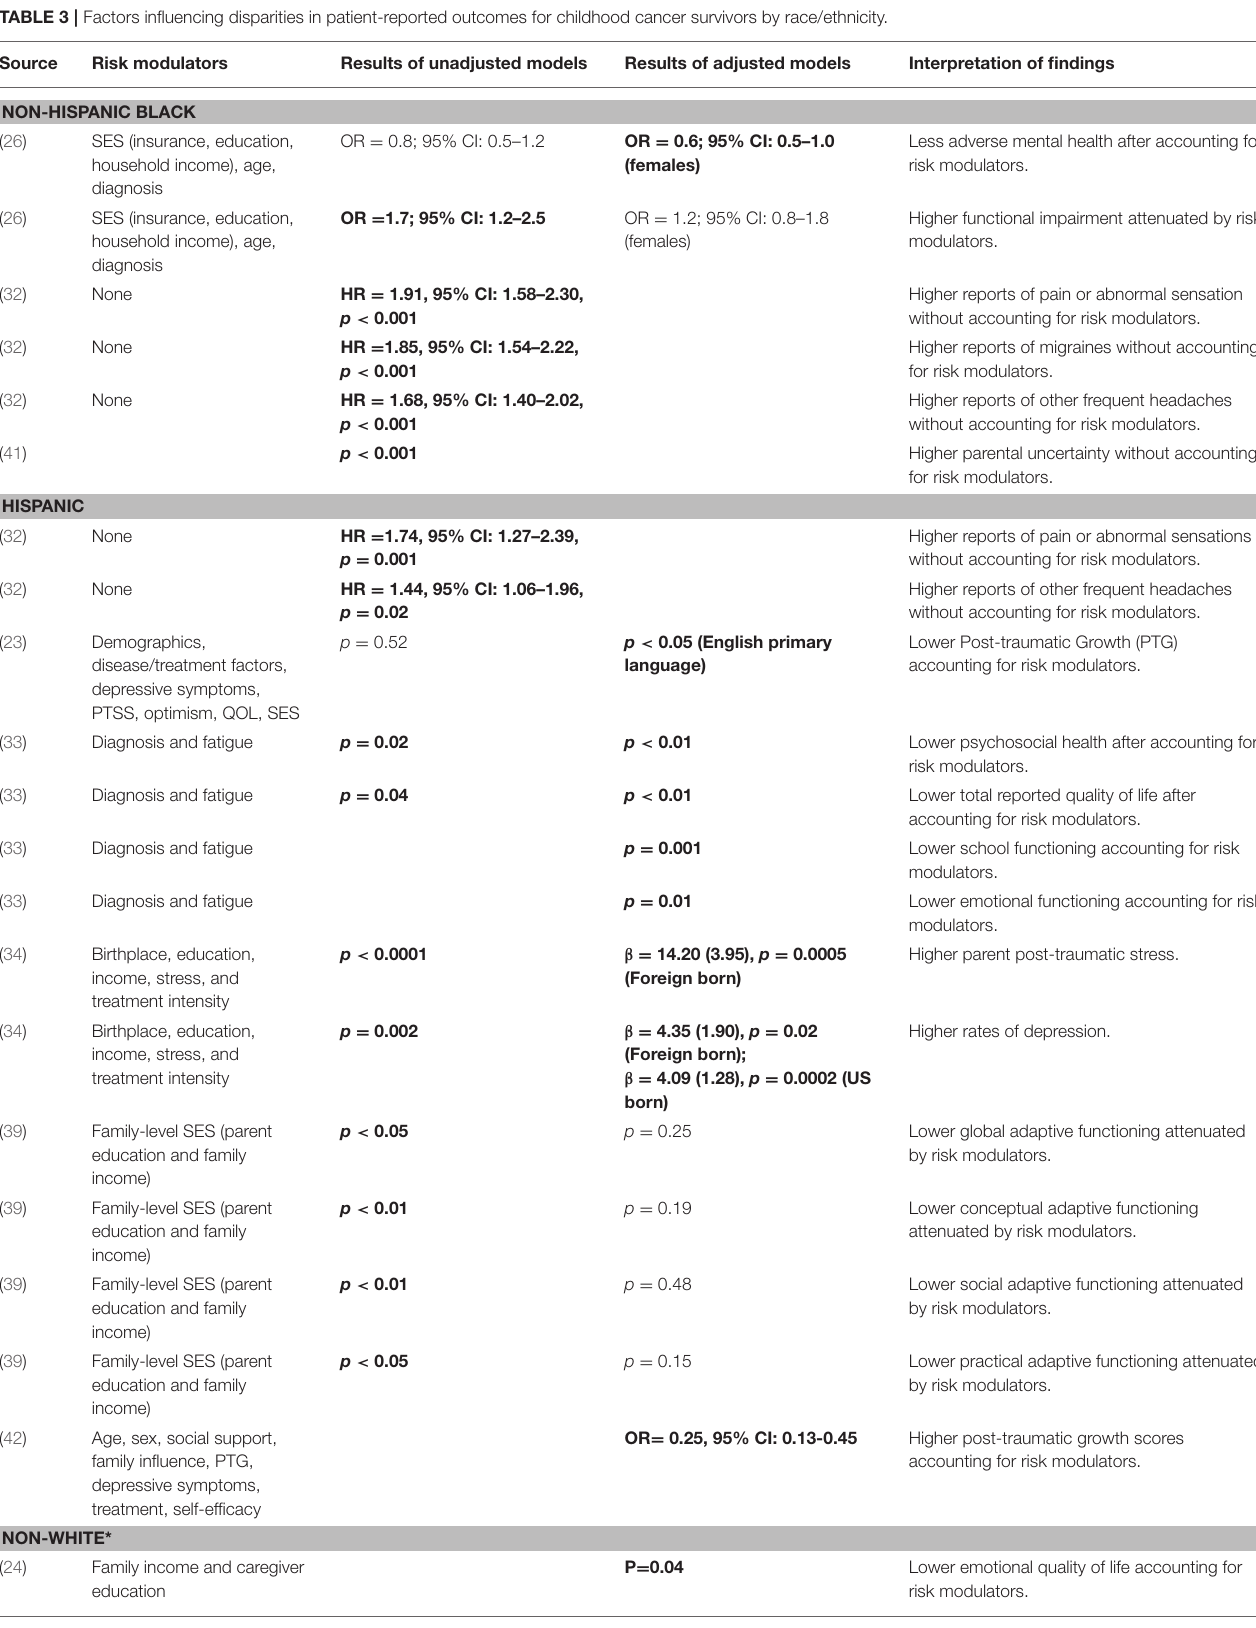
TABLE 3 | Factors influencing disparities in patient-reported outcomes for childhood cancer survivors by